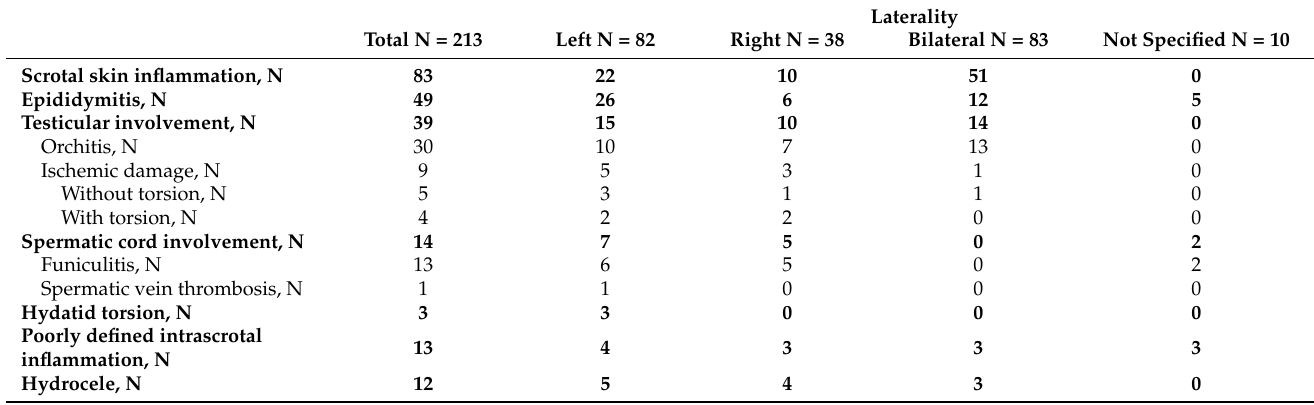
Table 4. Scrotal structures involved in 96 males with Henoch–Schönlein